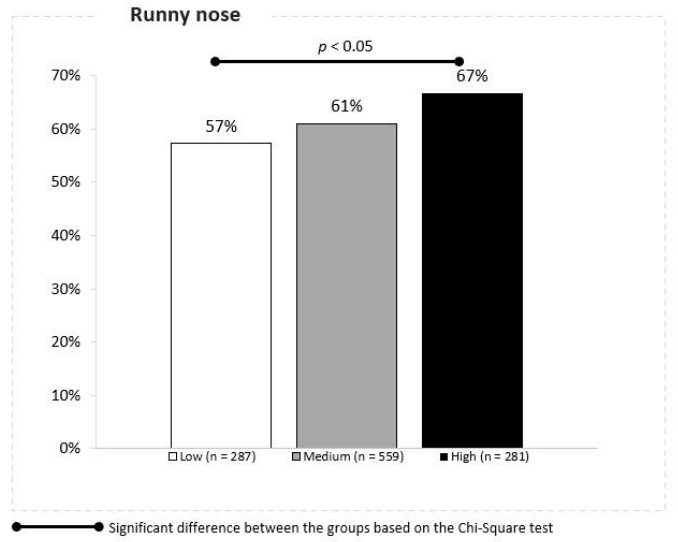
Figure 5. Association between the PM 2.5 concentrations and runny nose.